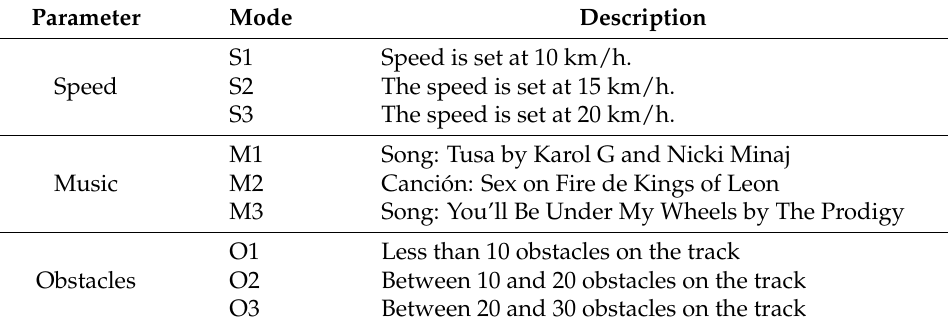
Table 2. Customized parameters of the virtual environment. Each variable has 3 different options to select from a total of 24